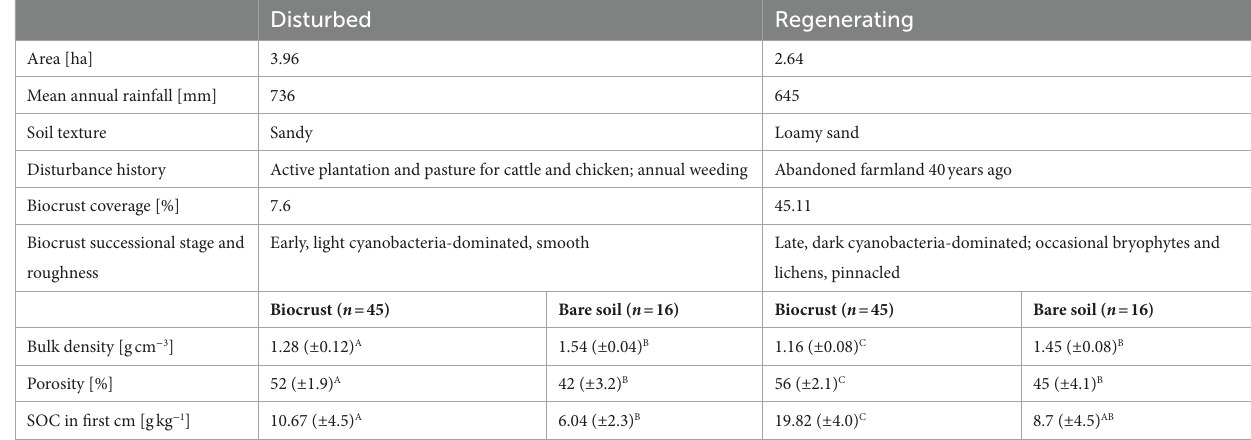
TABLE 1 Description of the two case study sites, including area, mean annual precipitation, soil texture, disturbance history, biocrust coverage, successional stage, and roughness, bulk density, porosity, and soil organic carbon (SOC) in biocrusts and bare control soil.